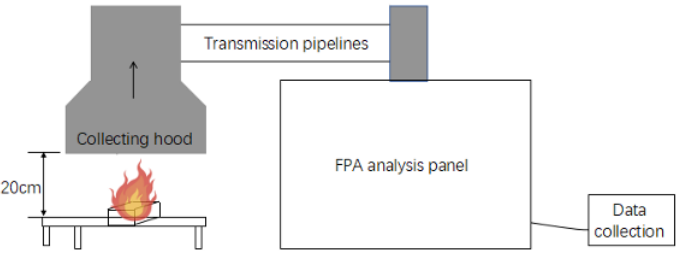
Fig. 3. Experimental platform